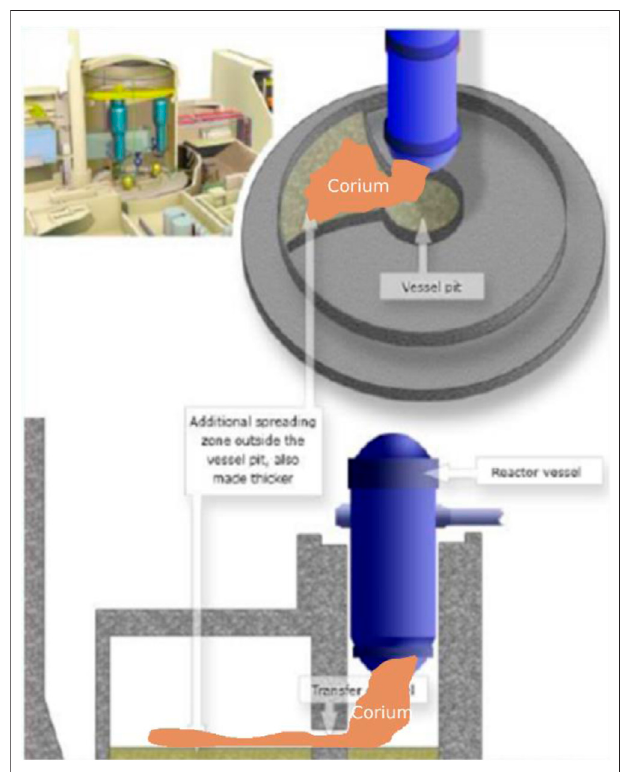
FIGURE15 | Ex-Vessel RetentionStrategyand corium spreading over a large surface, as adapted from Bonnet, et al.